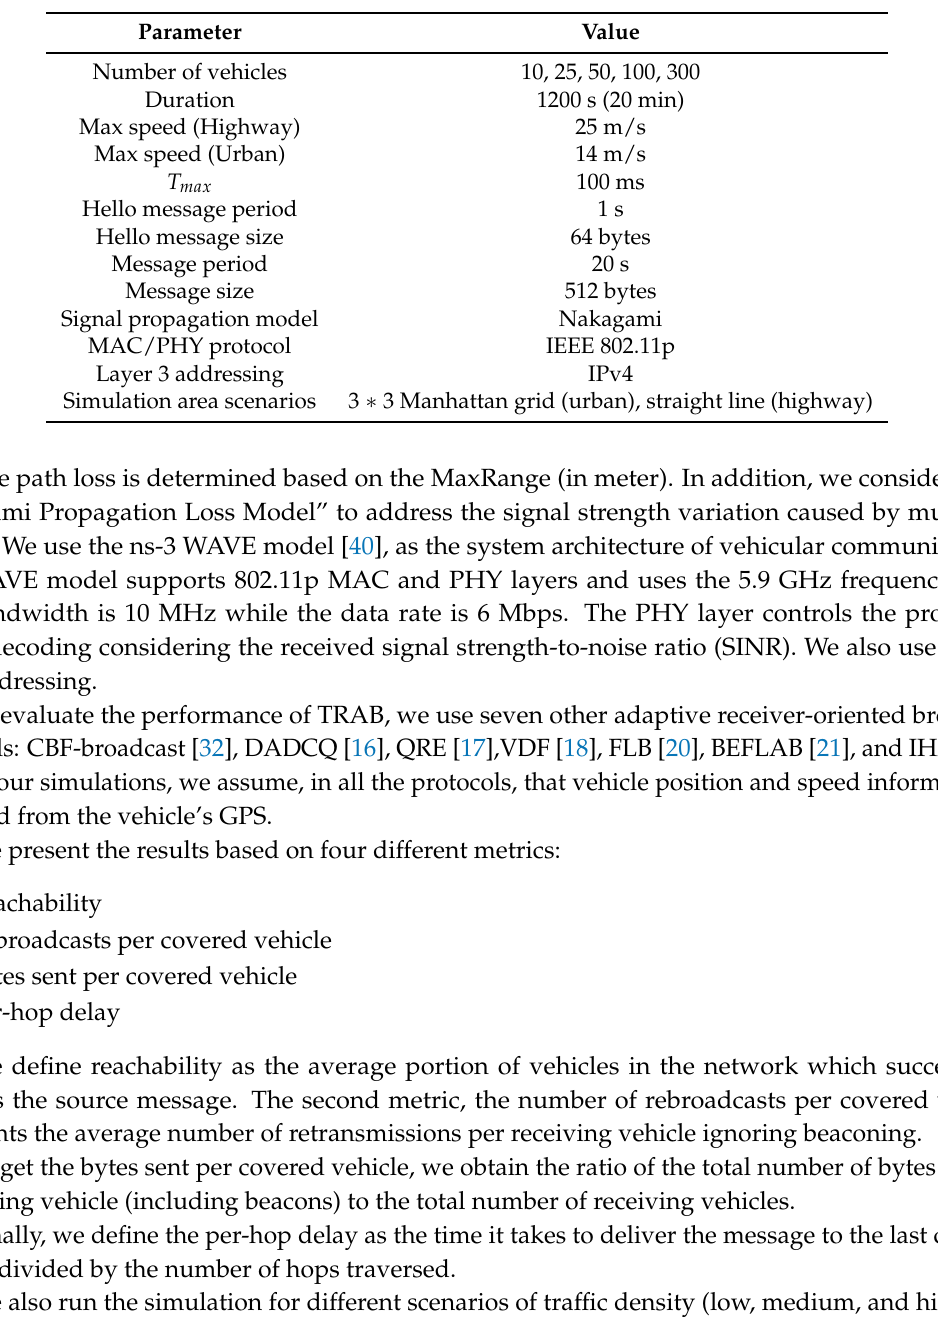
Table 4. The simulation